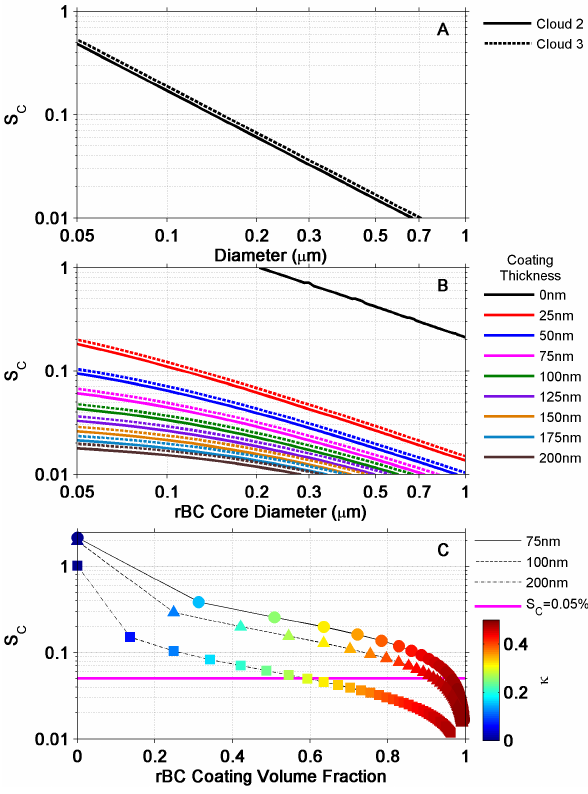
Figure 8. Panel (a) shows the critical supersaturation ( S C , black lines) as a function of particle dry diameter based on measured AMS bulk compositions and an ion-pairing scheme. Panel (b) shows S C as a function of rBC core diameters with coatings ranging from 0 to 200nm. In (b) , the coatings are assumed to have the same com- position as the bulk residual aerosol (Fig. 7). The solid lines are for Cloud 2 and the dashed lines are for Cloud 3. Panel (c) shows S C as a function of rBC coating volume fraction at three different rBC core diameters (75, 100, and 200nm), where each data point is colored by its corresponding κ . Also shown in panel (c) is the estimated S C (pink line) determined for both clouds in this